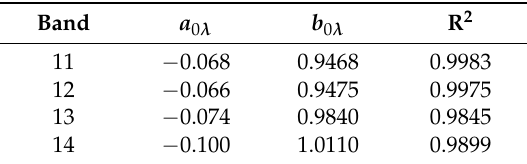
Coefficients for the linear relationship between atmospheric transmittance ( τ λ ) and